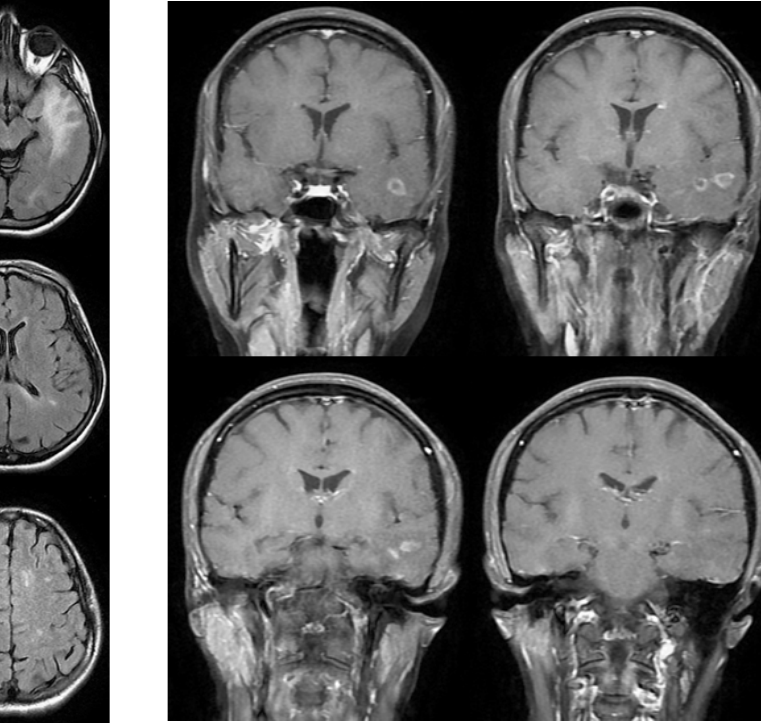
Figure 1. Axial FLAIR MRI revealed multiple periventricular and subcortical plaques and TMS in the right temporal lobe.